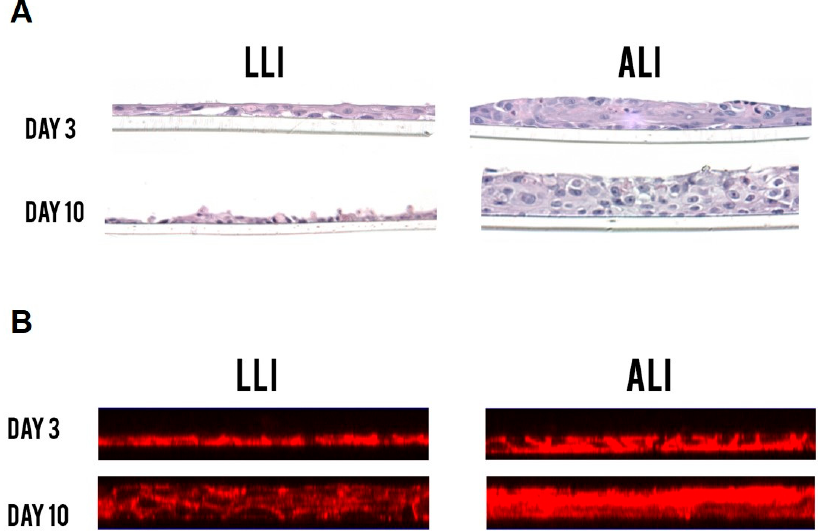
Figure 2. Hematoxylin and eosin (H&E) staining ( A ) and filamentous F-actin staining ( B ) comparison between the LLI and the ALI interface of Vk2 cells after 10 days of culture. Vk2 cells in ALI culture grew into multilayered epithelium compared to the monolayers seen in LLI. All samples were imaged on Leica HC DMR microscope under a 40 × objective (Leica Microsystems). A minimum of three replicates per experimental condition was included. Representative images are